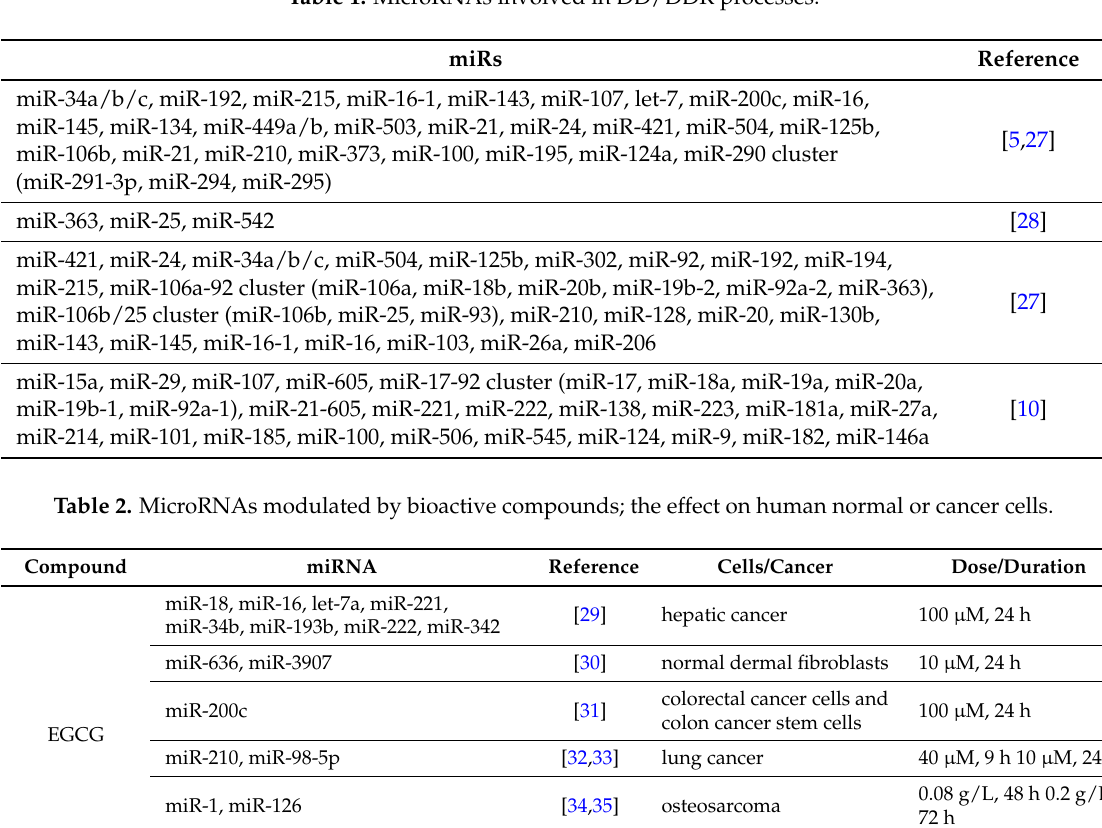
Table 1. MicroRNAs involved in DD/DDR processes.